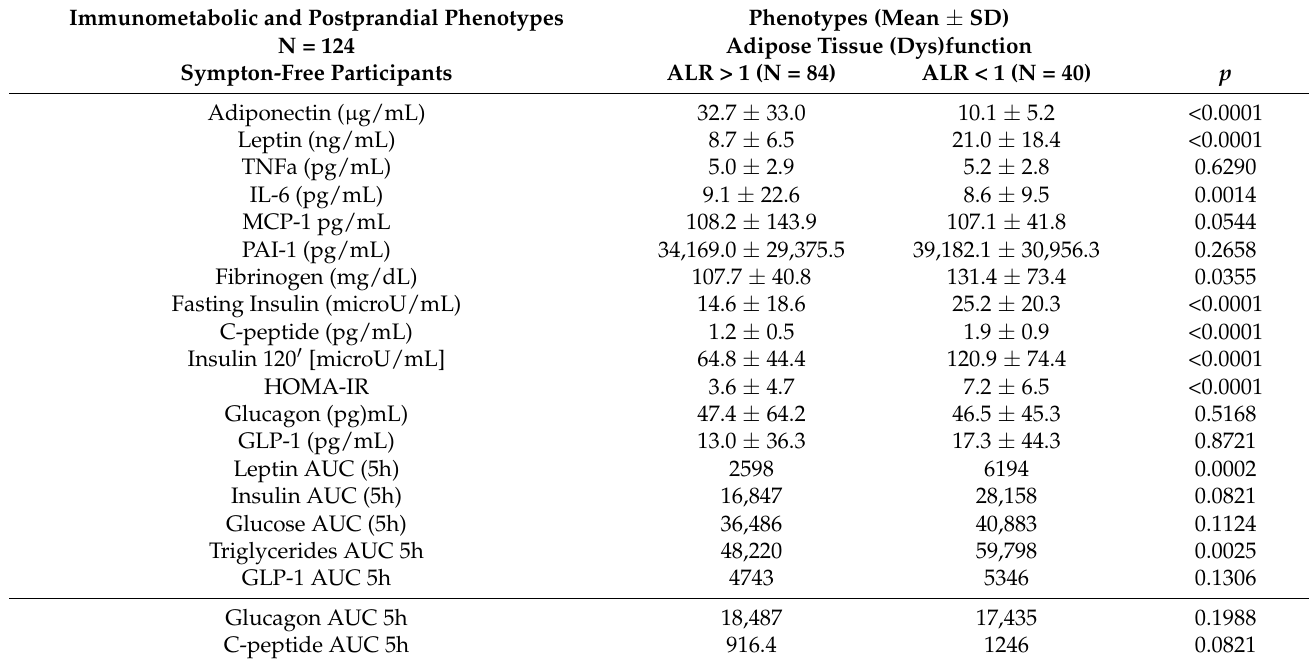
Table 2. Immunometabolic and postprandial parameters for the adipose tissue dysfunction phenotype in our symptom-free GEMM volunteers.